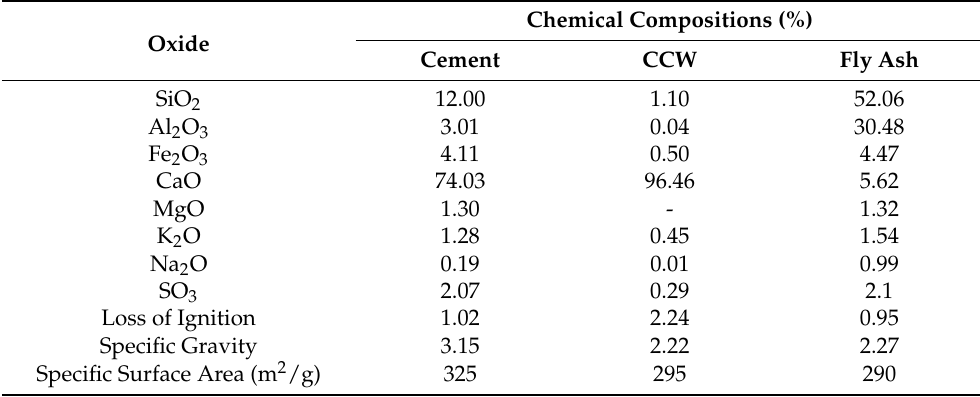
Table 1. Chemical properties of